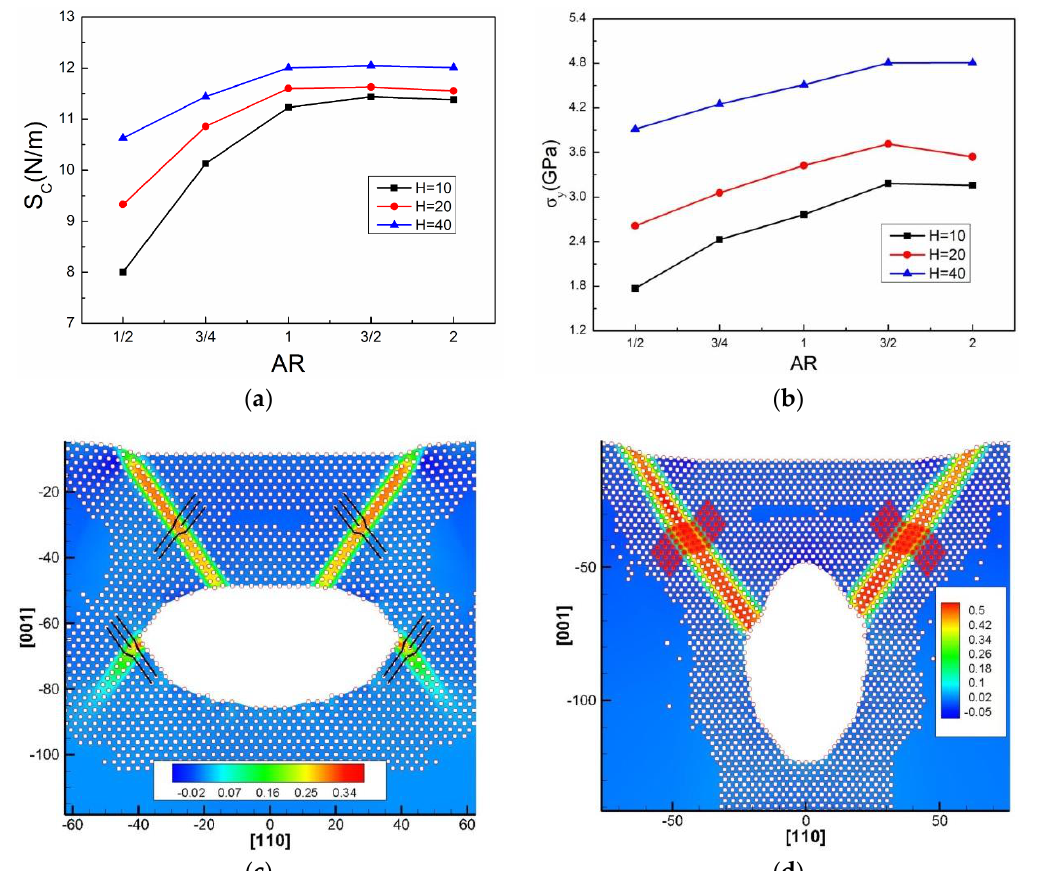
Figure 6. ( a ) Contact stiffness ( S c ) and ( b ) yield stress ( σ y ) of Al containing an elliptical cavity with different aspect ratios AR ( AR = L / R ) during nanoindentation. The dislocation morphology of the matrix at the yield point for the cavity cases of ( c ) ( AR = 1/2, H = 40 Å, R = 40 Å, S = 80 Å) and ( d ) ( AR = 2, H = 40 Å, R = 20 Å, S = 80 Å ).